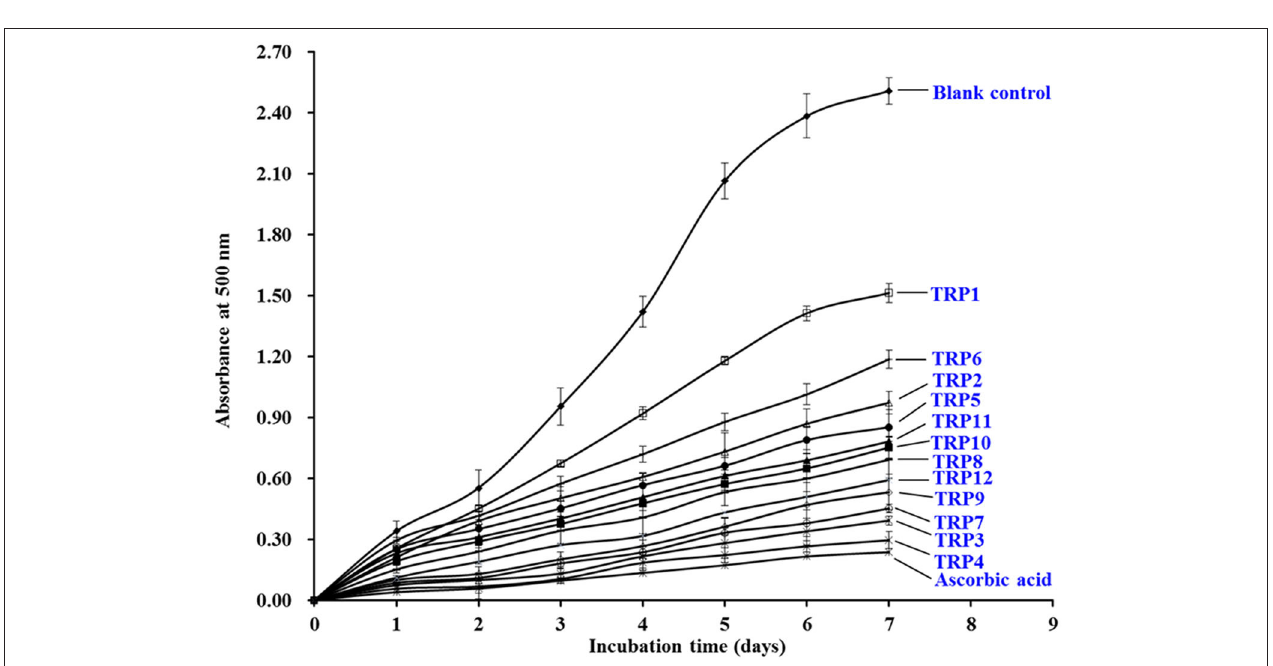
FIGURE 7 | The lipid peroxidation inhibition assays of 12 isolated APs (TRP1 to TRP12) from TRPH. The data are presented as the mean ± SD ( n = 3).